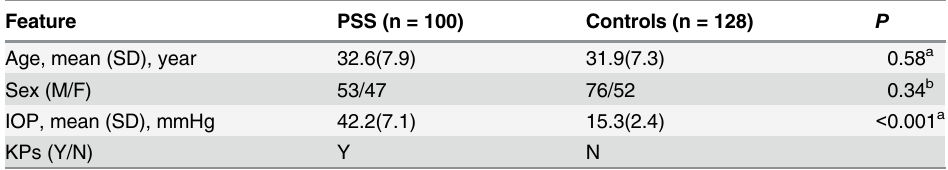
Table 1. The demographic and clinical features of the PSS cases and